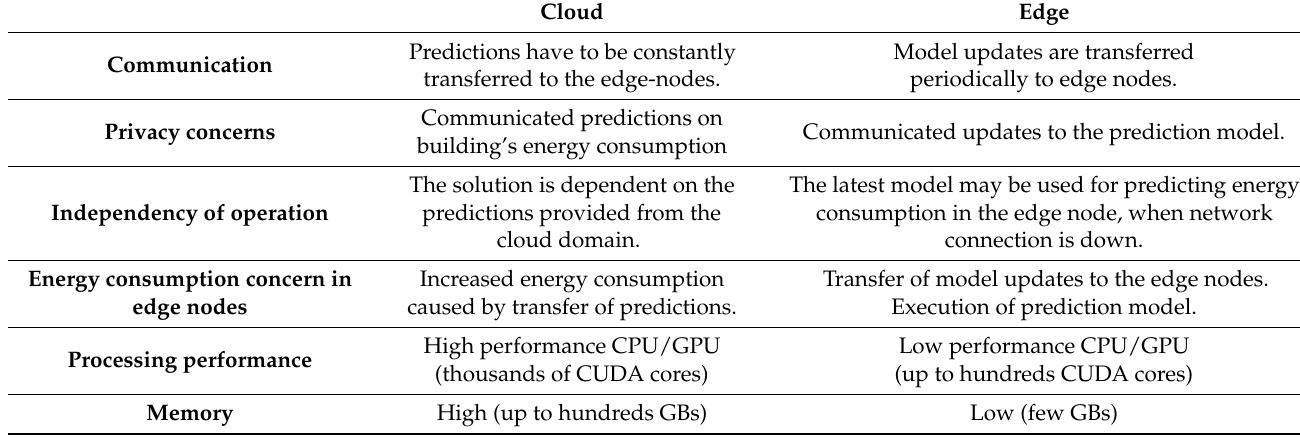
Table 1. Comparison between placing prediction/inference functionality in cloud or edge domains. Cloud = prediction model is executed in cloud domain, and predictions are transferred to edge nodes; Edge = prediction model is transferred from the cloud domain to edge nodes for